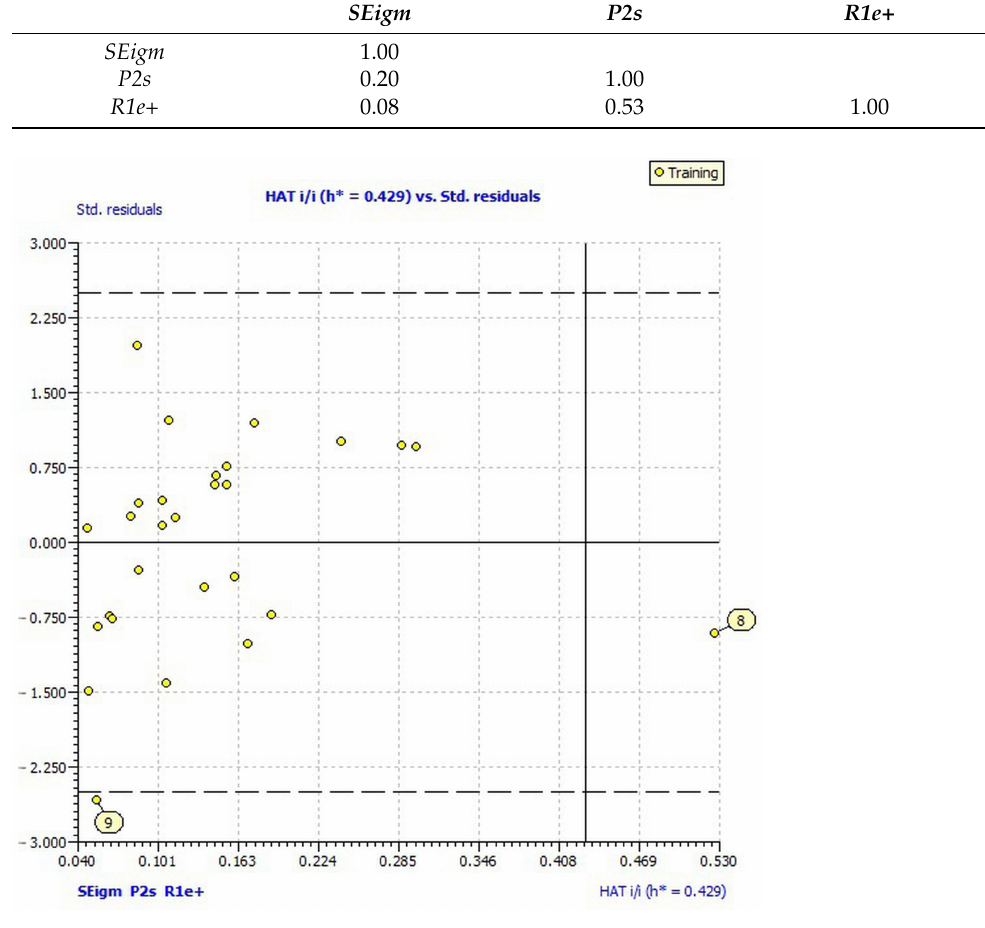
Table 7. Correlation matrix (correlation coefficient, R ) for the descriptors included in model (2).